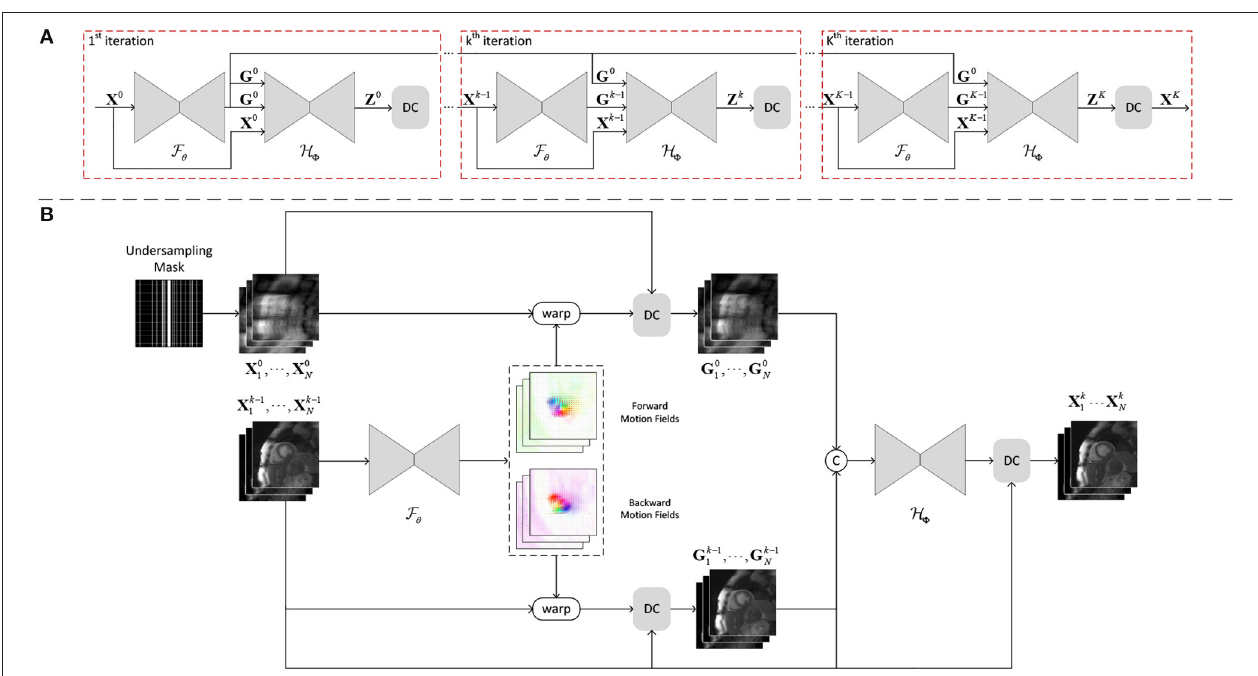
FIGURE 2 | (A) The unrolled architecture of GRDRN for K iterations, where F θ and H 8 is the groupwise registration and dynamic reconstruction network respectively. (B) The detailed framework of the k -th iteration in GRDRN. The groupwise registration network F θ takes as input the reconstructed dynamic images from the previous iteration and outputs the invertible motion fields between the implicit template and dynamic images. The reconstruction network H 8 denoises the dynamic images with additional inputs of the motion augmented dynamic sequences. After the data consistency layer (DC), the denoised dynamic images will be inputted to the next